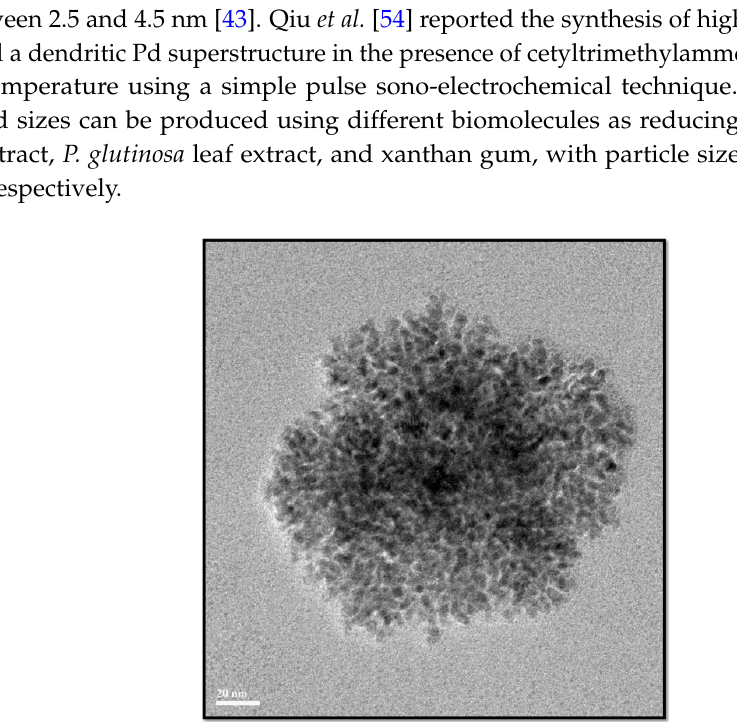
Figure 5. Transmission electron microscopy (TEM) images of palladium nanoparticles (PdNPs).